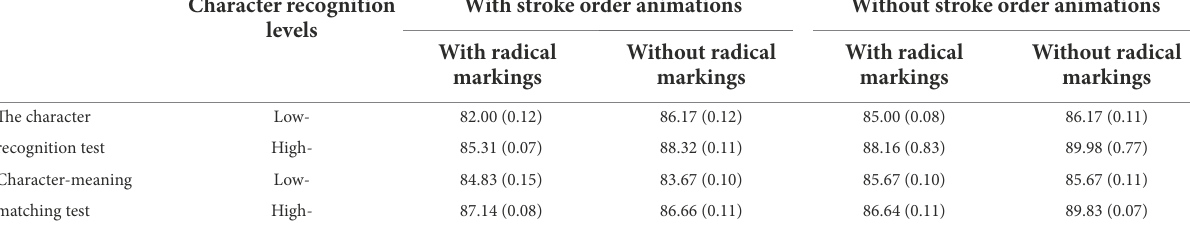
TABLE 1 Mean accuracy (%) and standard deviation (in parentheses) of the immediate